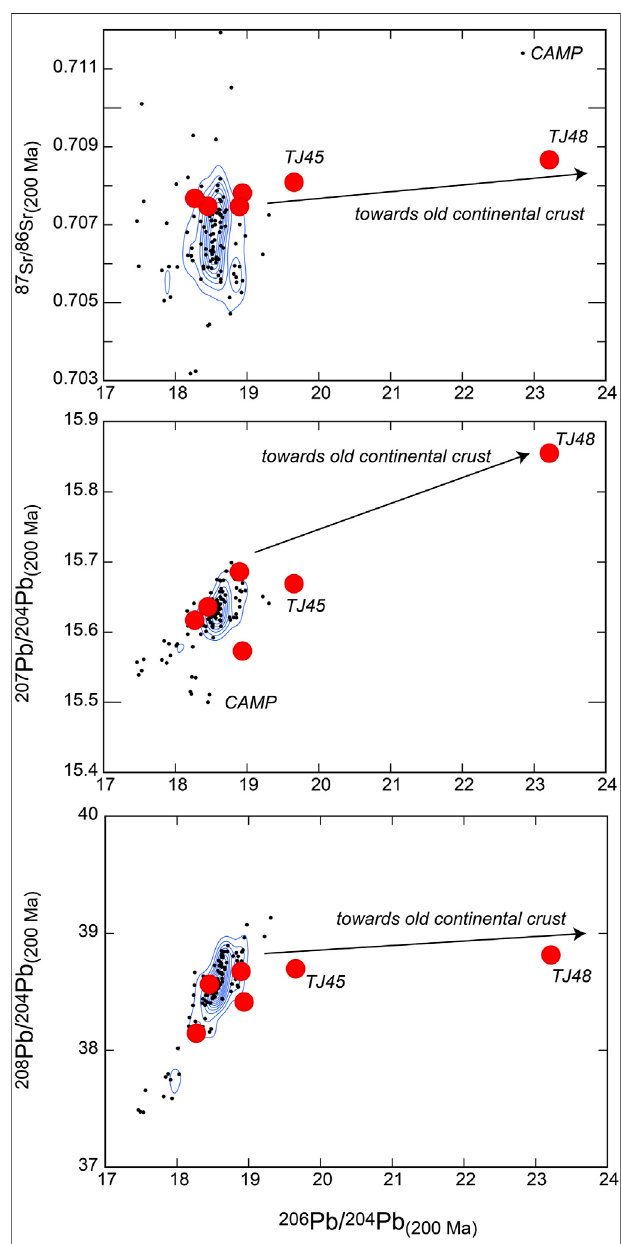
FIGURE 5 | 87 Sr/ 86 Sr, 207 Pb/ 204 Pb, and 208 P/ 204 Pb versus 206 Pb/ 204 Pb plots of six samples of the sequence that returned measurable Pb isotope ratios. Black dots are CAMP data from GeoRoc (http://georoc.mpch-mainz. gwdg.de/georoc/). Blue lines show density contours generated with RStudio software. For discussion see text.